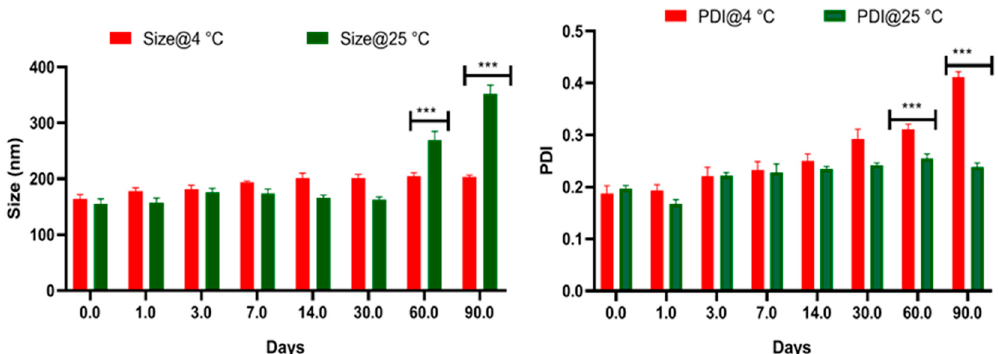
Figure 6. Stability analysis of minocycline loaded albumin nanoparticle performed by measuring change in particle size and PDI of lyophilized powder stored at either 4 °C or 25 °C over a 3-month time. Values shown here represent SD ( n = 3). Two-way Anova, Multiple comparison analysis *** p < 0.001.